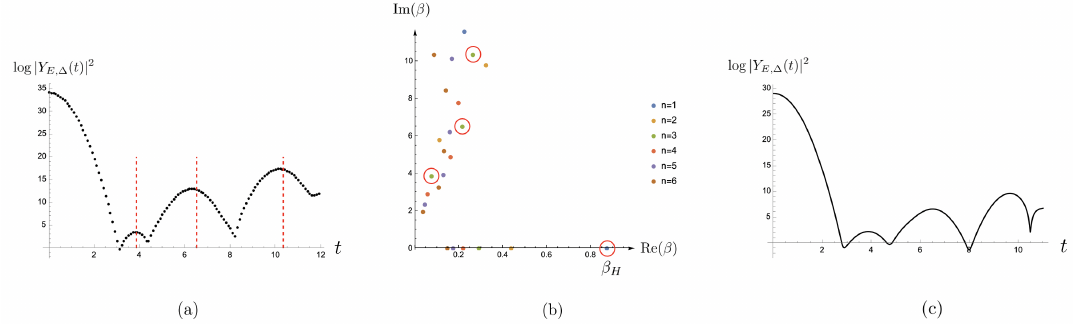
Figure 7 . (a) In the first example (2.5) with parameters E = 0 . 1 N 2 , ∆ 2 = 0 . 2 N 2 , we circle out the zeros for which the corresponding saddles will dominate. (b) We plot the analytic prediction for the spectral form factor. The red dashed lines are located at the imaginary parts of the circled zeros in (a).